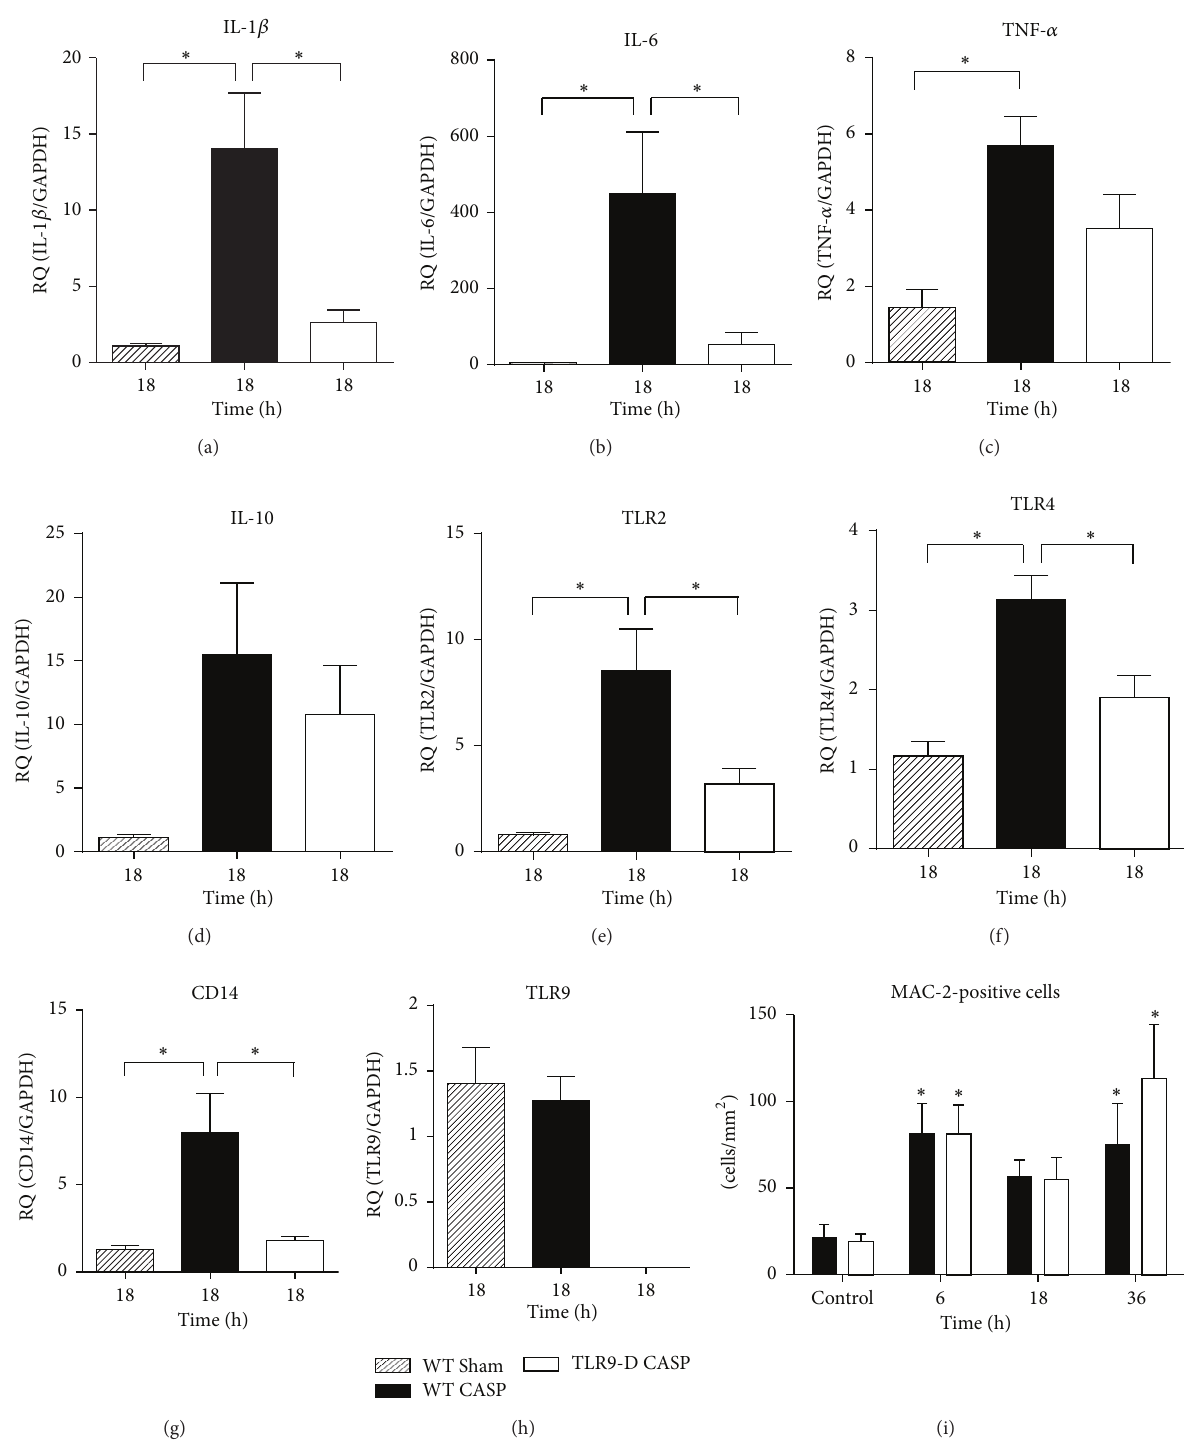
Figure 4: Comparison of inflammatory parameters in WT and TLR9-D mice. (a)–(h) Cardiac cytokine and TLR mRNA expressions were compared between WT Sham, WT CASP, and TLR9-D CASP hearts 18h after surgery ( ∗ : 𝑃 < 0.05 ; 𝑛 = 10/ group; mean ± SEM). (i) Quantification of MAC-2-positive macrophages in immunohistochemically stained sections of the heart of control and CASP mice 6 h, 18h, and 36h after surgery (WT: white bars; TLR9-D: black bars; ∗ : 𝑃 < 0.05 versus respective control; 𝑛 = 6/ group; mean ±